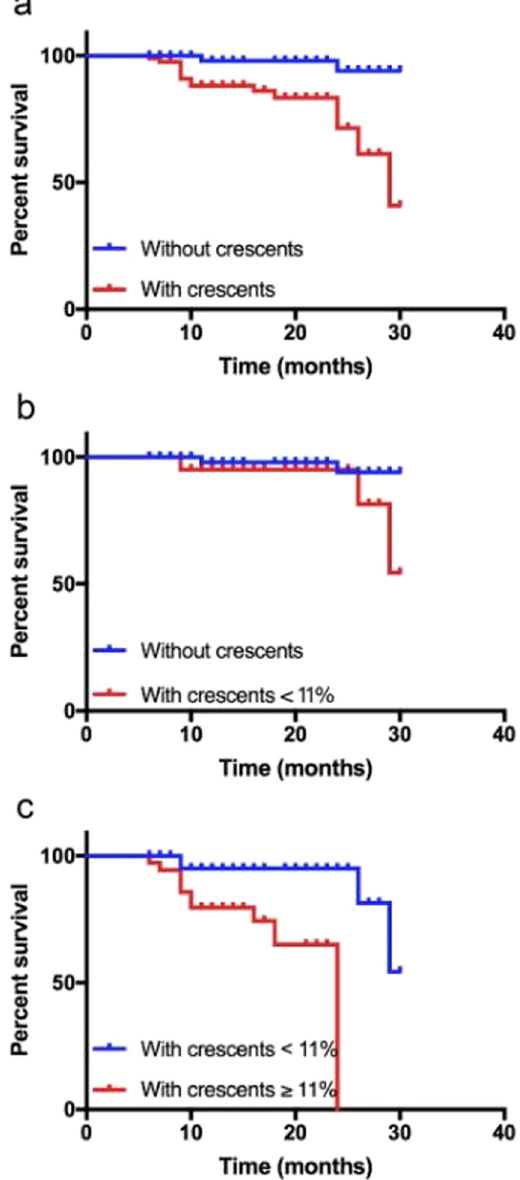
Figure 2: Kaplan – Meier survival analysis of IgAN patients with dif - ferent C proportions: ( a ) C - free patients vs those with Cs, ( b ) C - free patients vs those with < 11% of glomeruli containing Cs, and ( c ) patients with < 11% of glomeruli containing Cs vs those ≥ 11% of glomeruli with